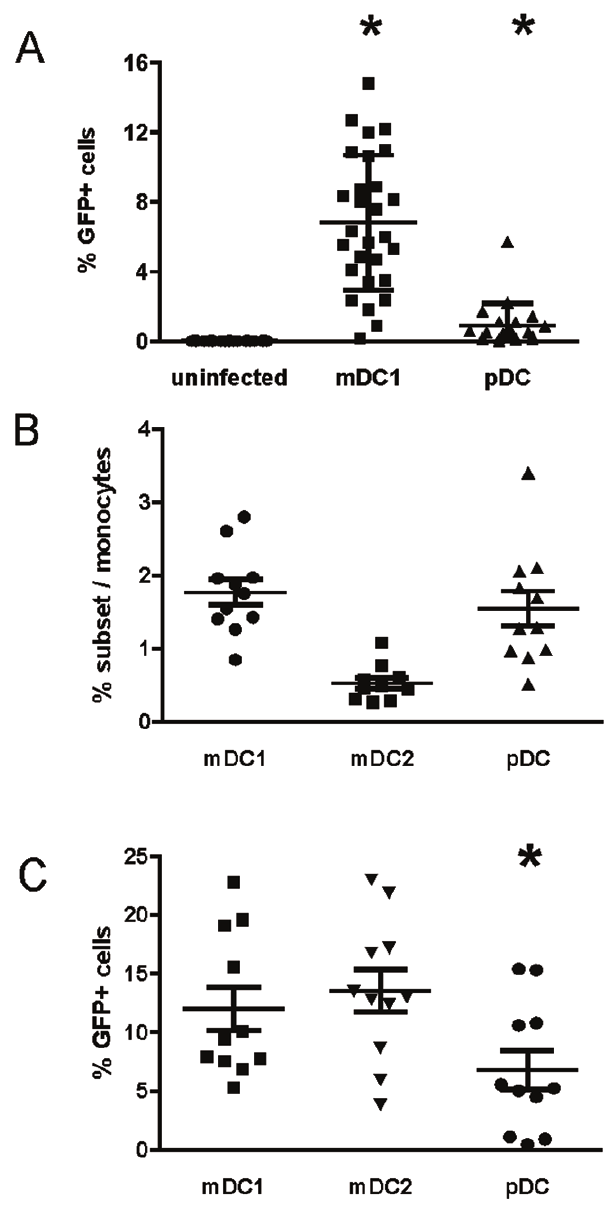
Figure 1. Frequency and RSV infection rates of primary mDC1, mDC2 and pDC. PanelA – Primary pDC and mDC1 were sequentially isolated from elutriated human monocytes in the first cohort of donors by magnetic selection and infected with rgRSV (moi=5) as described in N the Materials and Methods. The percentage of infected (GFP + ) cells was , n=27), determined 18–24 hrs post-infection for mock-infected cells ( mDC1 ( & , n=27), and pDCs ( m , n=20). Relative to mock-infected cells, significantly more mDC1 and pDCs are GFP + (p , 0.0001 and p=0.007, respectively). PanelB – In a second cohort of donors, pDC, mDC1, and mDC2 were sequentially isolated from elutriated monocytes. The cell subsets were counted and frequency within the elutriated monocytes calculated. Panel C – Following magnetic selection and overnight resting, mDC1, mDC2, and pDC were exposed to live rgRSV (moi=5). Twenty-four hours after infection, uninfected and infected cells were fixed and analyzed by flow cytometry. Data are represented as the percentage of GFP + cells within live DCs. For panels B and C, N=11 donor samples with 1 donor present for 2 separate visits. * = significantly different from mDC1 and mDC2, p ,